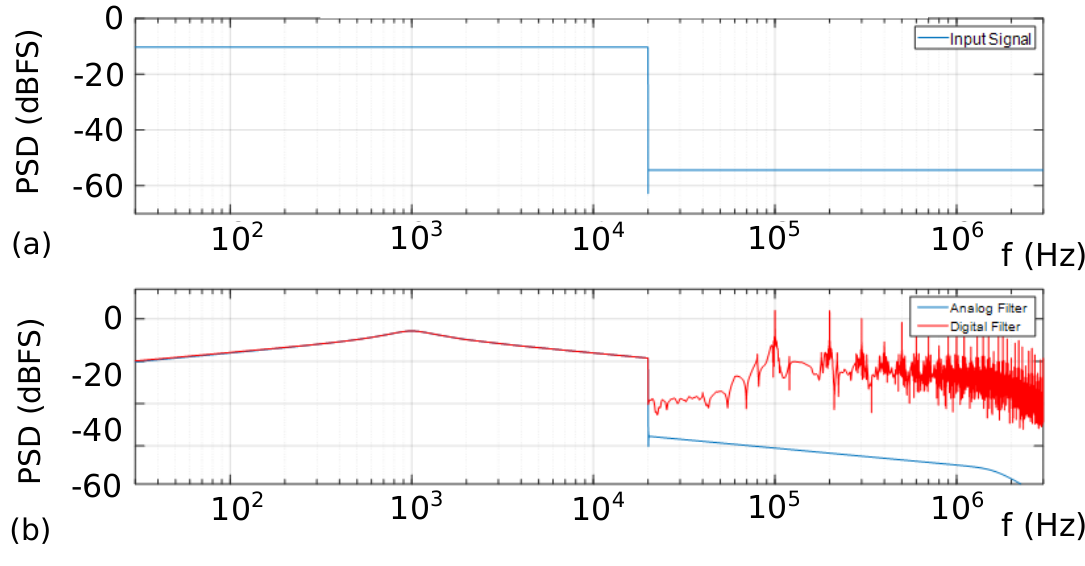
Figure 5. Behavioral simulation with sinc function as the input signal: ( a ) input signal spectrum; and ( b ) output signal spectrum (in blue the output spectrum with conventional bi-quad filter and in red the output spectrum with proposed VCO-based bi-quad